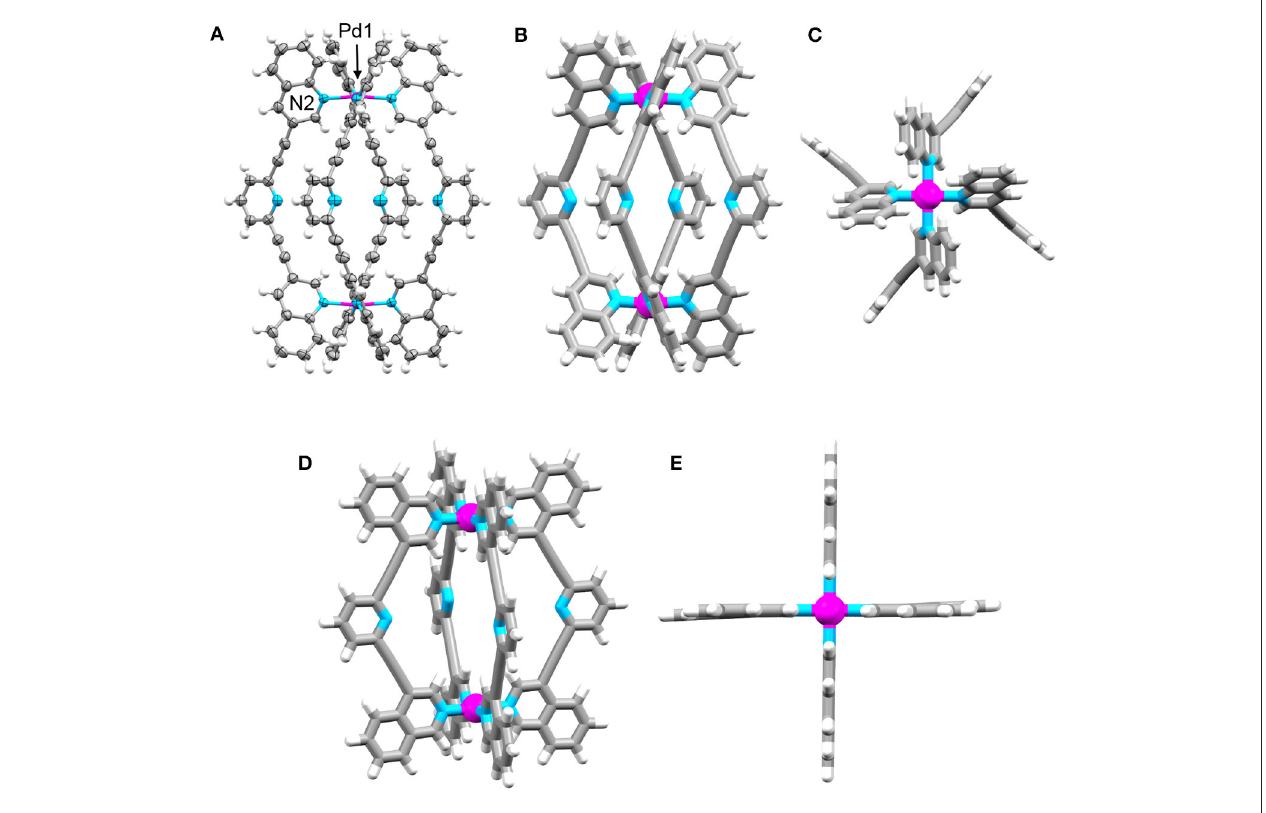
FIGURE 3 | Molecular structures of C q and C iq . X-ray structure of C q : (A) ellipsoid side view, (B) tube side view, and (C) tube top view showing paddle-like array of quinoline panels over palladium(II) center. Solvent molecules and counterions have been omitted for clarity. Ellipsoids are shown at 50% probability. DFT optimized (BP86 def2-SVP) model of C iq ; (D) side view and (E) top view showing lantern-shaped structure. Colors: carbon gray, nitrogen blue, palladium magenta, hydrogen white.